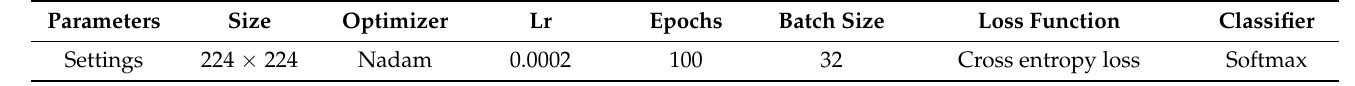
Table 7. Configuration of training parameter values for Comparison